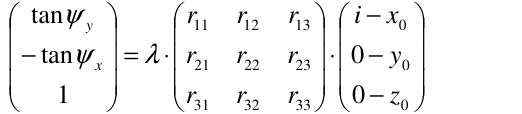
Figure 1. Line-of-sight reference system (X C ,Y C ,Z C ), detector coordinate system (X F ,Y F ,Z F ) and instrument view angles ( x ψ y